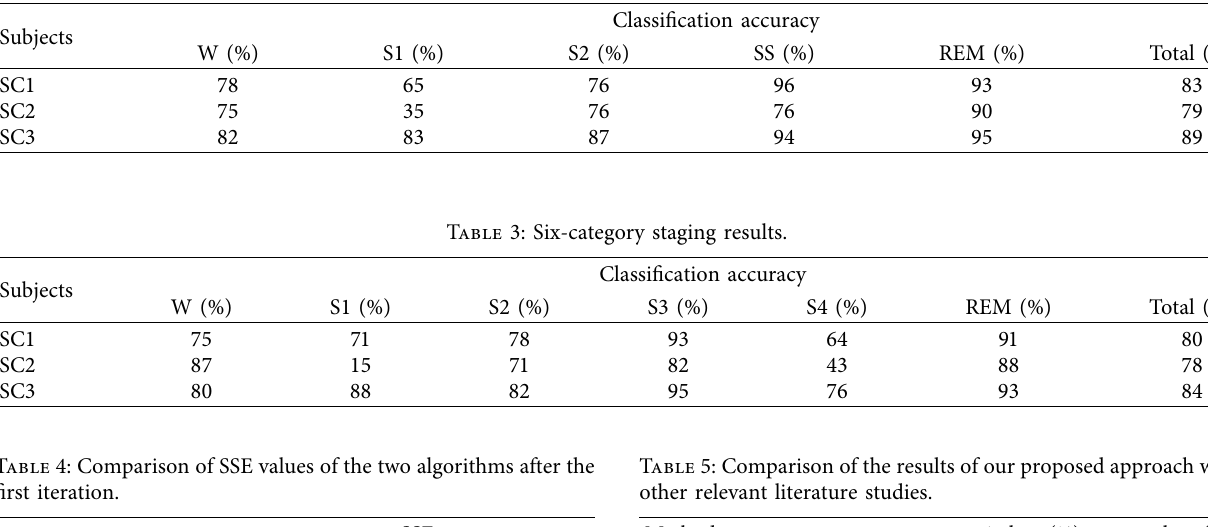
Figure 10: Different K values for clustering experiments. Table 2: Five-category staging results.